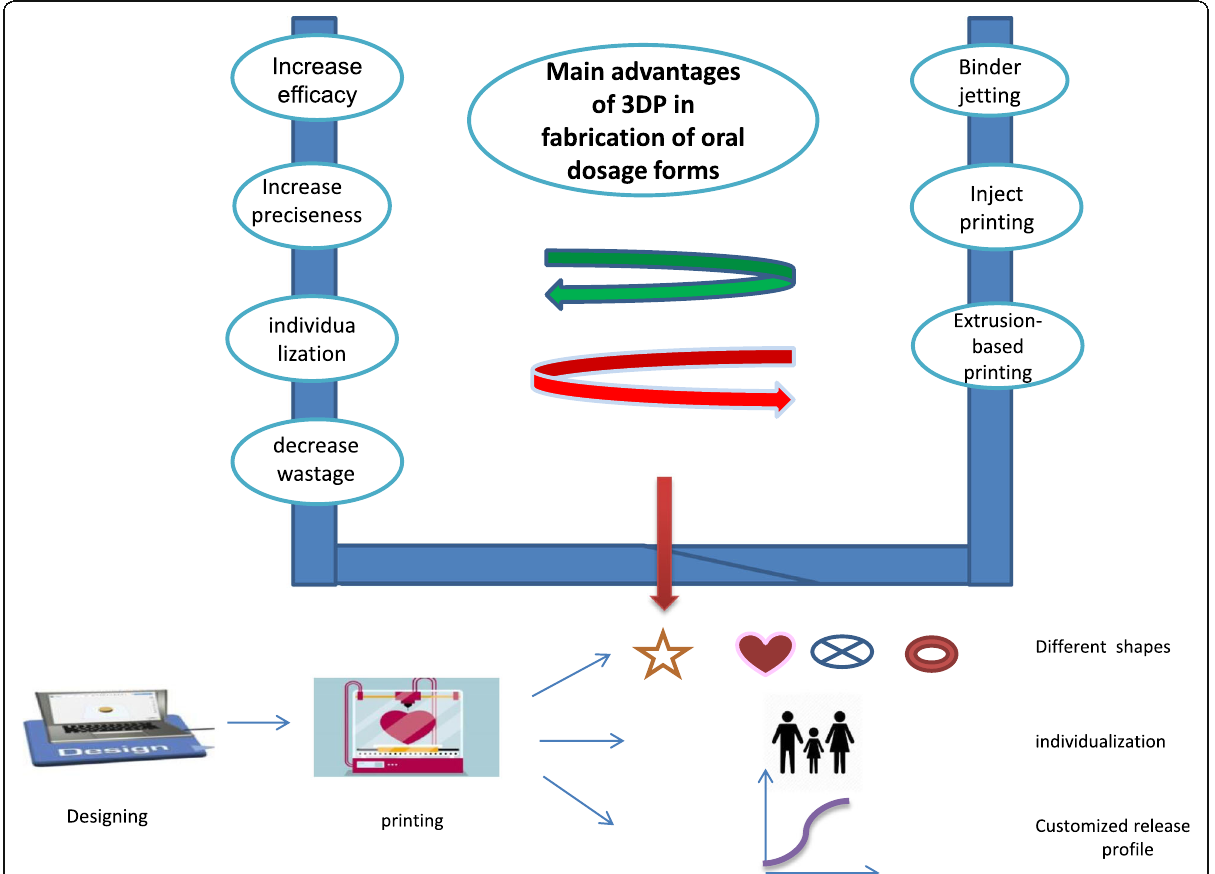
Fig. 1 Main advantages of 3D printing technology in the pharmaceutical